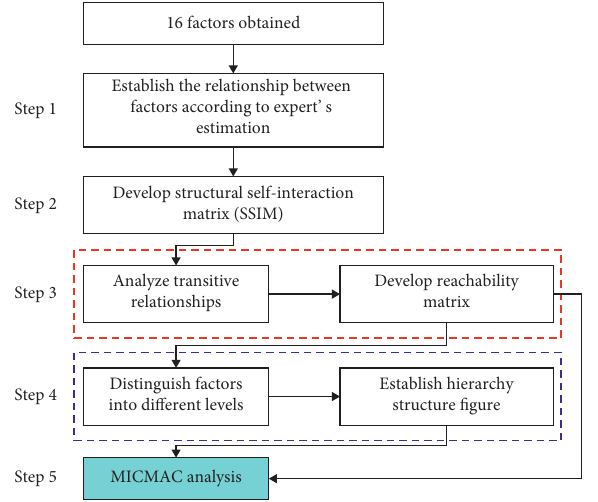
Figure 4: Implementing ISM process. Table 3: The structural self-interaction matrix (SSIM).